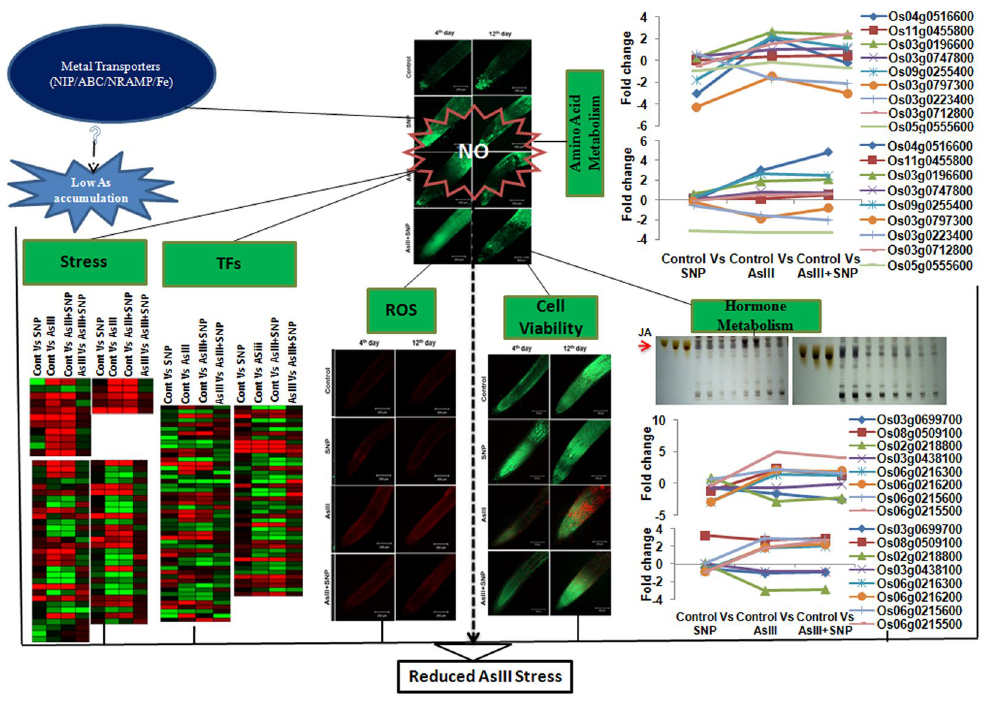
Figure 8. Schematic representation of NO-mediated AsIII stress detoxification mechanisms showing putative signaling among DEGs related to metal transport, stress response and several metabolic and cellular pathways in AsIII